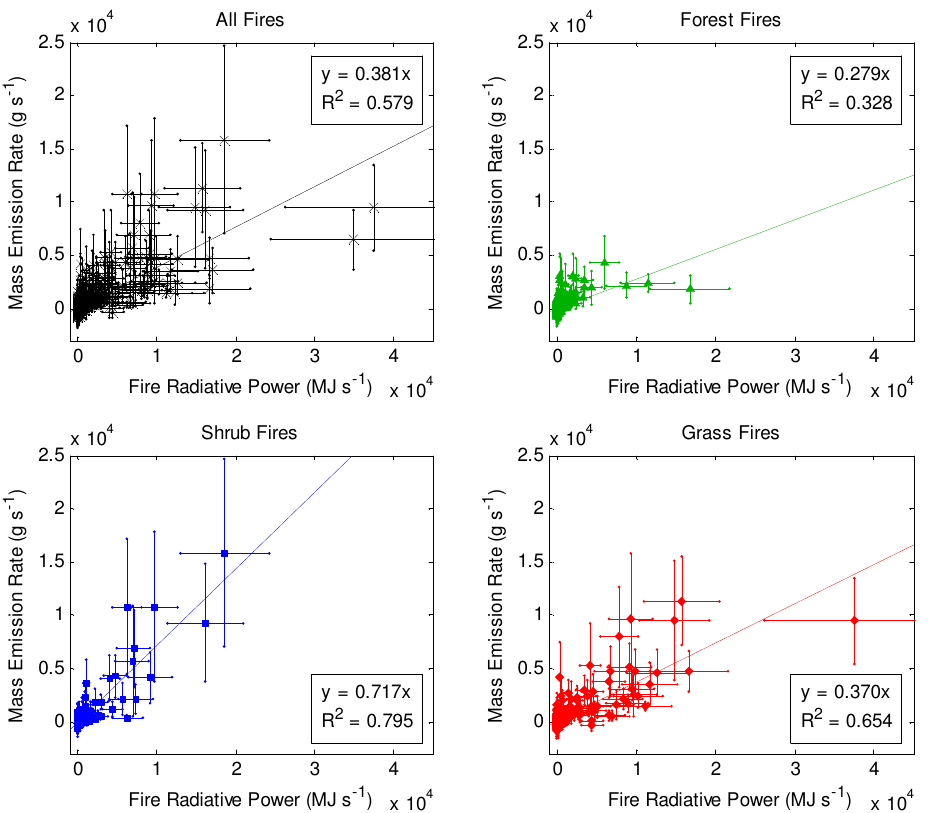
Fig. 3. Plots of fire radiative power (FRP) vs. NO 2 mass emission rate (MER) for fires grouped by land type: all (a) , forests (b) , shrubs (c) , and grasses (d) , with lines of best fit and R 2 values. Error bars are one standard deviation for MER and range for FRP as reported in the